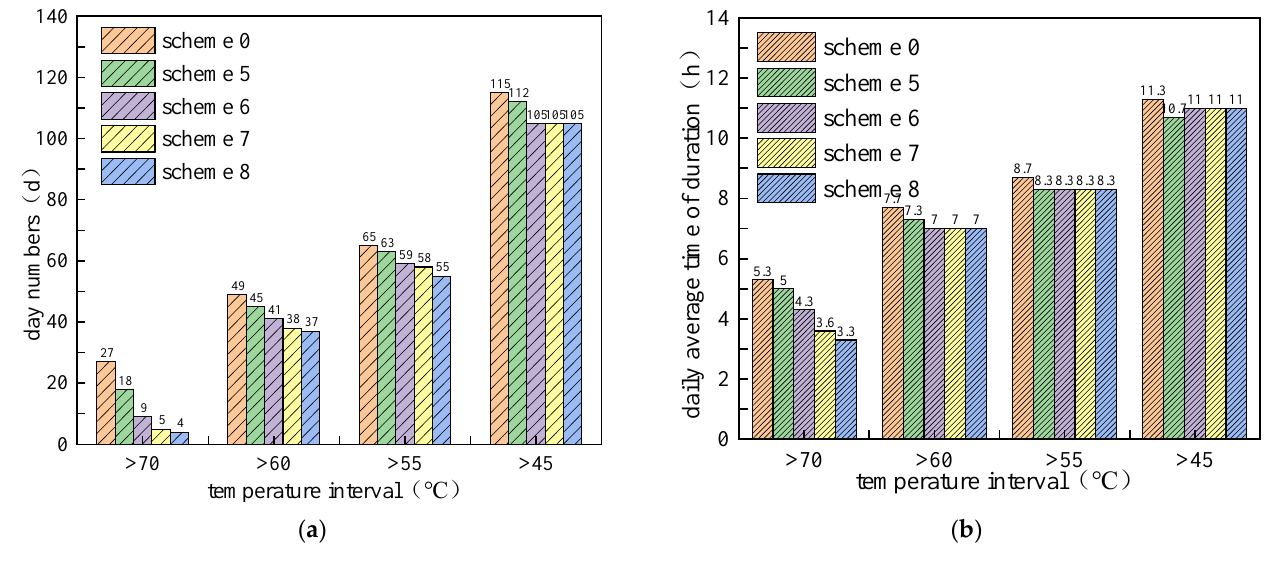
Figure 11. Duration times of daily maximum pavement temperature for different temperature ranges and PCM mixing ratio: ( a ) number of days; ( b ) daily average duration in hours.